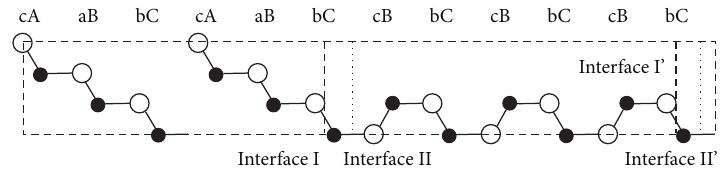
Figure 1: Schematic diagram of one unit cell in CdS ZB/WZ heterocrystalline superlattice with 6 zinc-blende (ZB) and 6 wurtzite (WZ) atomic layers. Empty circle represents S atom and solid circle represents Cd atom. Vertical dashed and dotted lines indicate the locations of abrupt interfaces I and II, respectively.